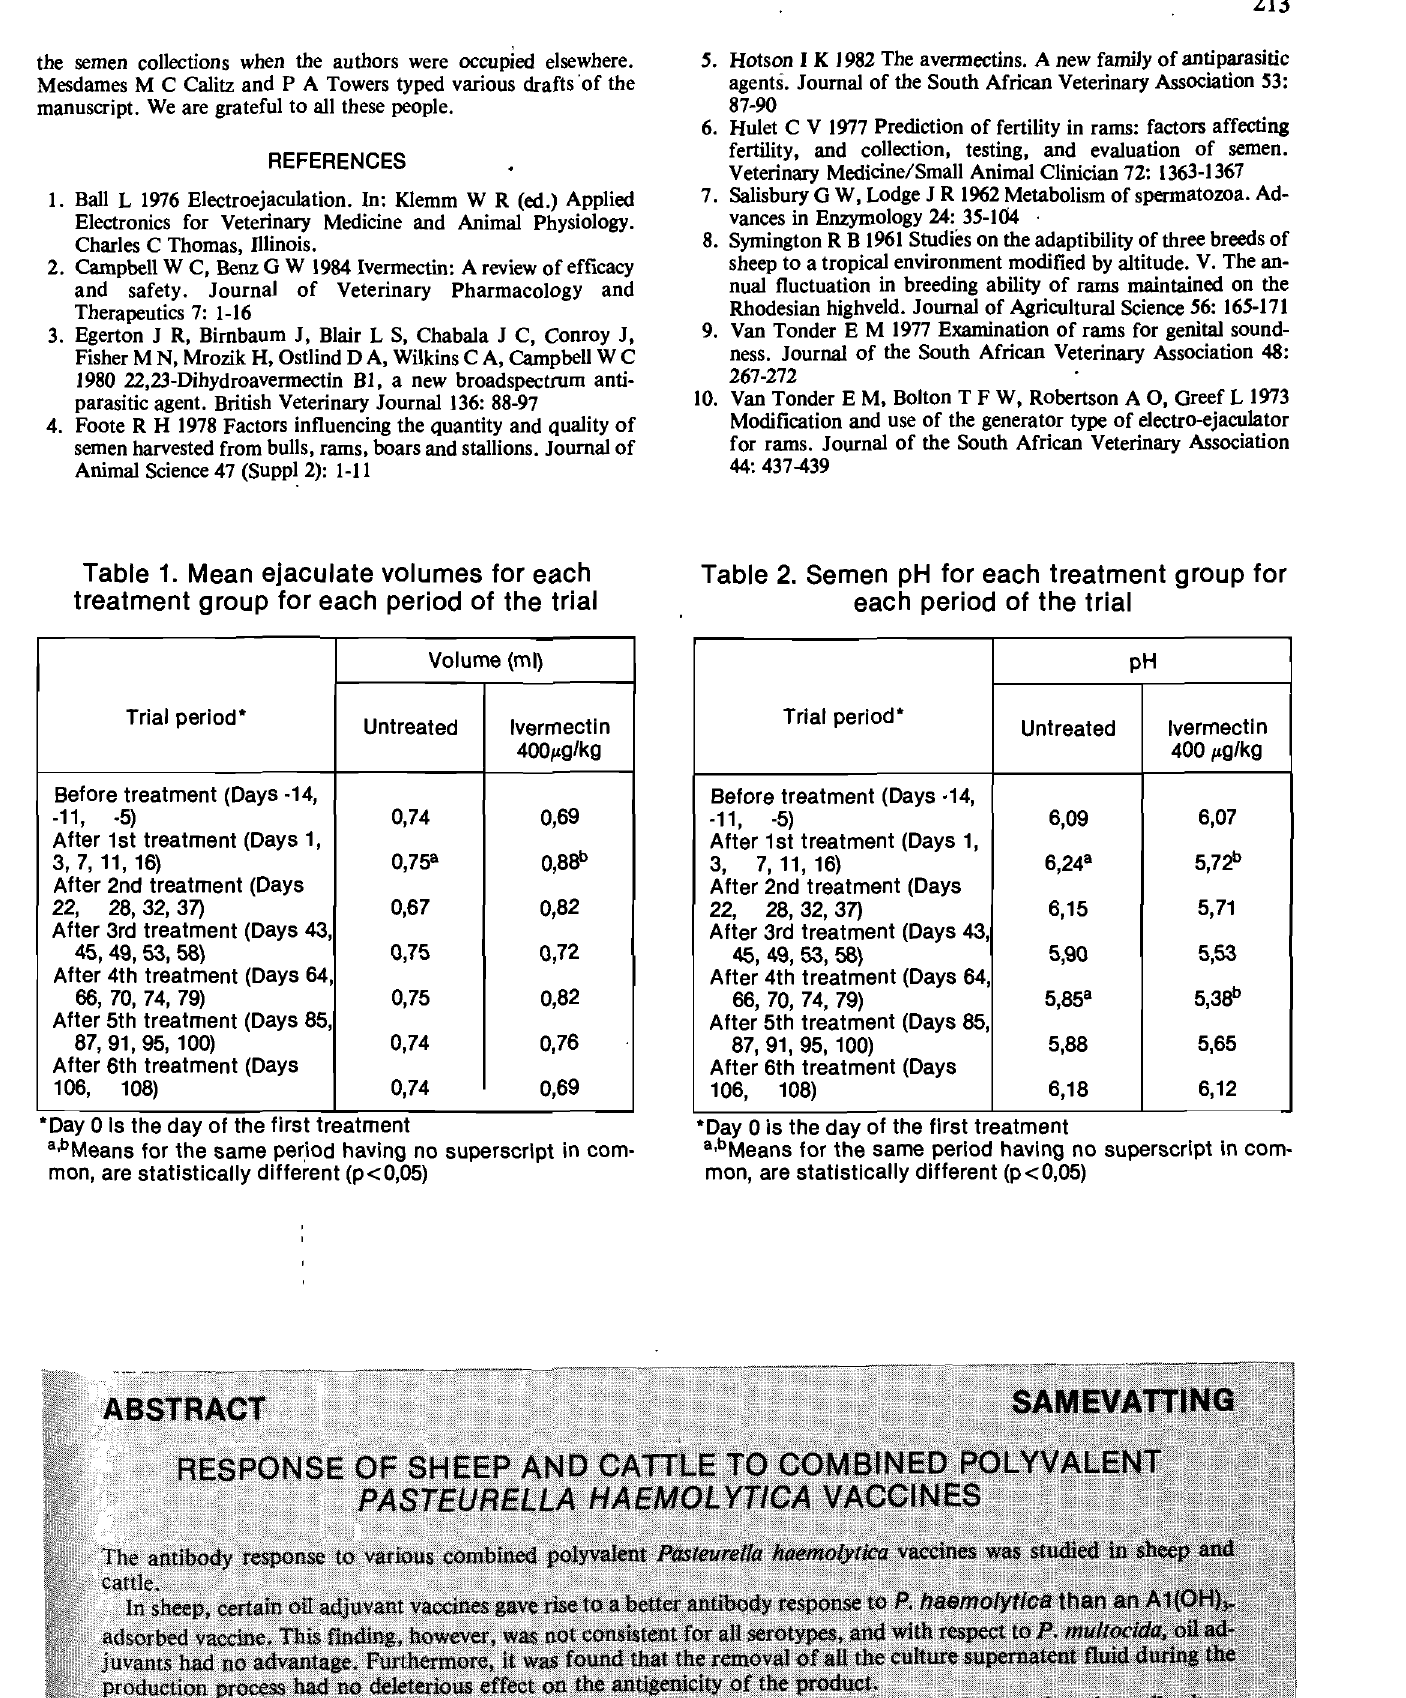
mon, are statistically different